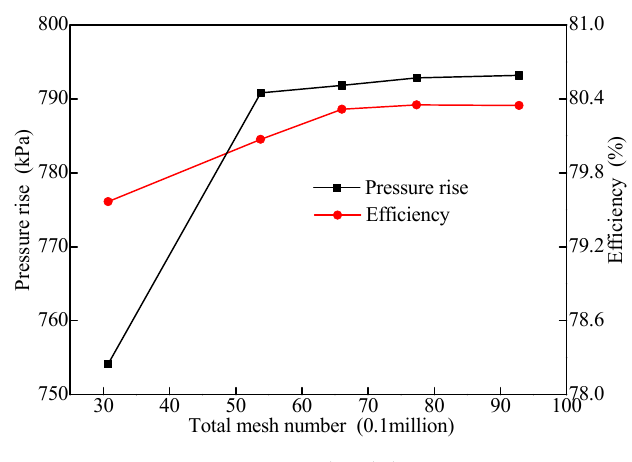
Figure 4. Mesh validation. Table 2. Supercharging and efficiency in relation to mesh elements.